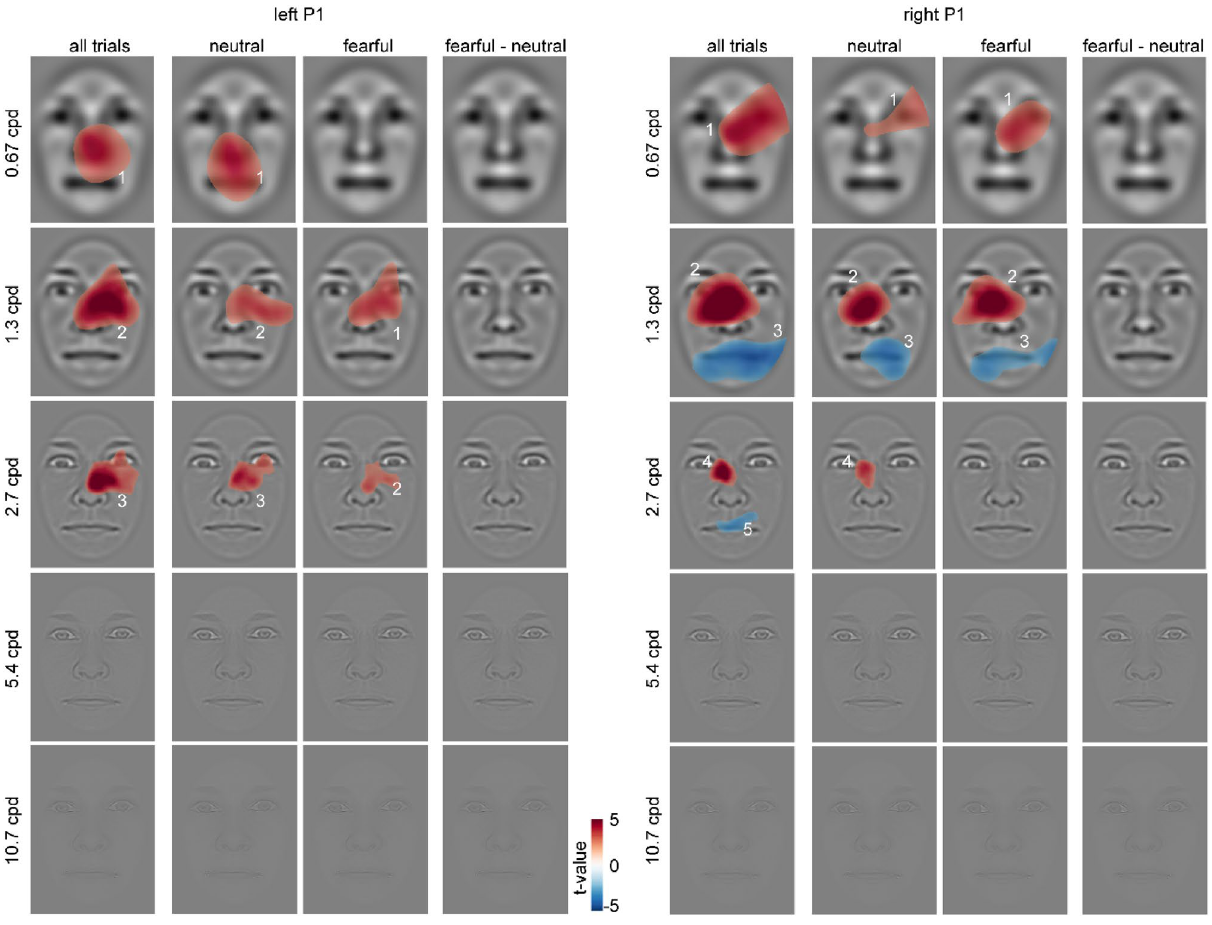
Figure 4. Classification images for the P1 component depicting face regions that contributed significantly to an amplitude increase (red) or decrease (blue). The clusters are enumerated to assign them to the respective statistics reported in the main text. Please note that the electrodes used for classification image calculations were chosen individually (see “Methods” section), whereas the ERP data in Fig. 3 are based on common sensors for